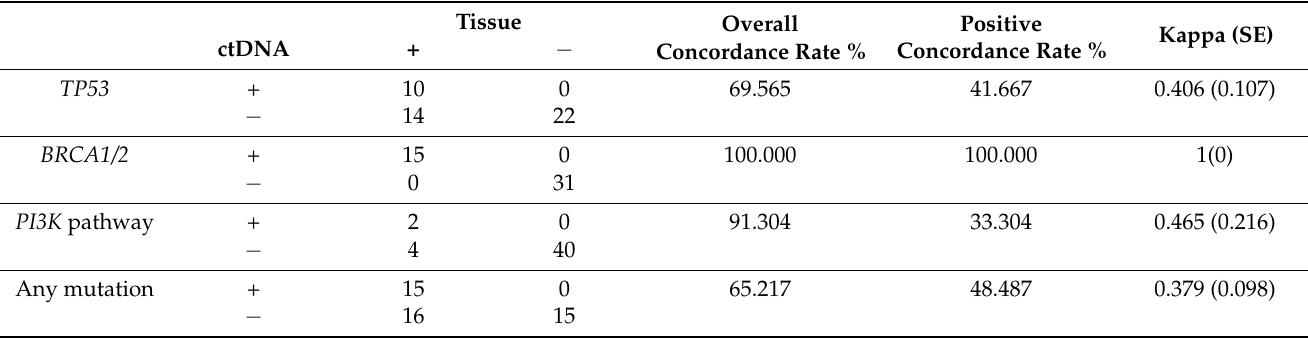
Table 2. Overall and positive concordance rates and Kappa values describing agreement categories